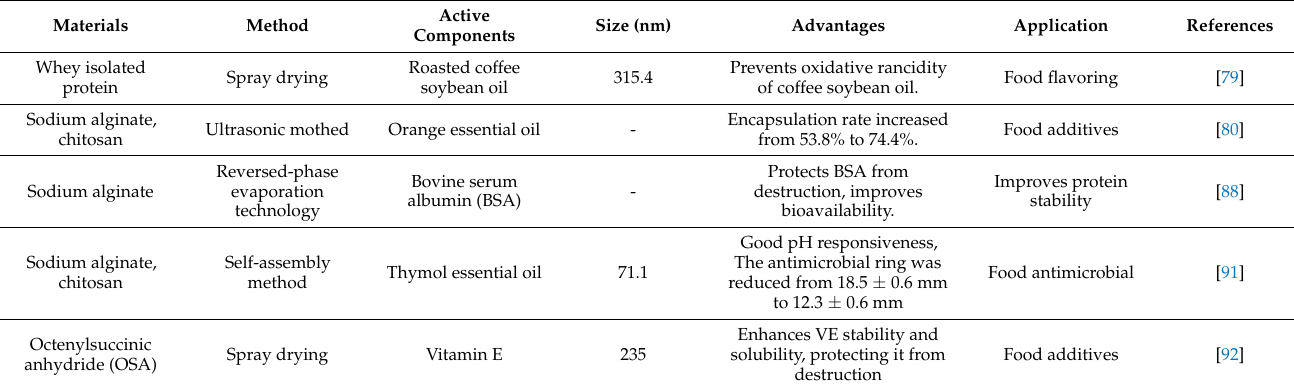
Table 3. Examples of nano-capsules for functional food nanoparticle delivery